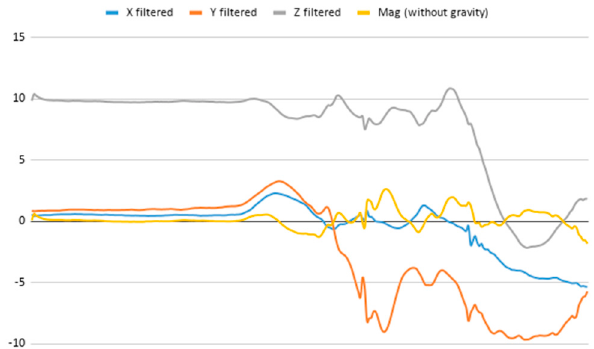
Figure 2. Representation of the filtered X, Y, and Z acceleration values as well as their magnitude without gravity.